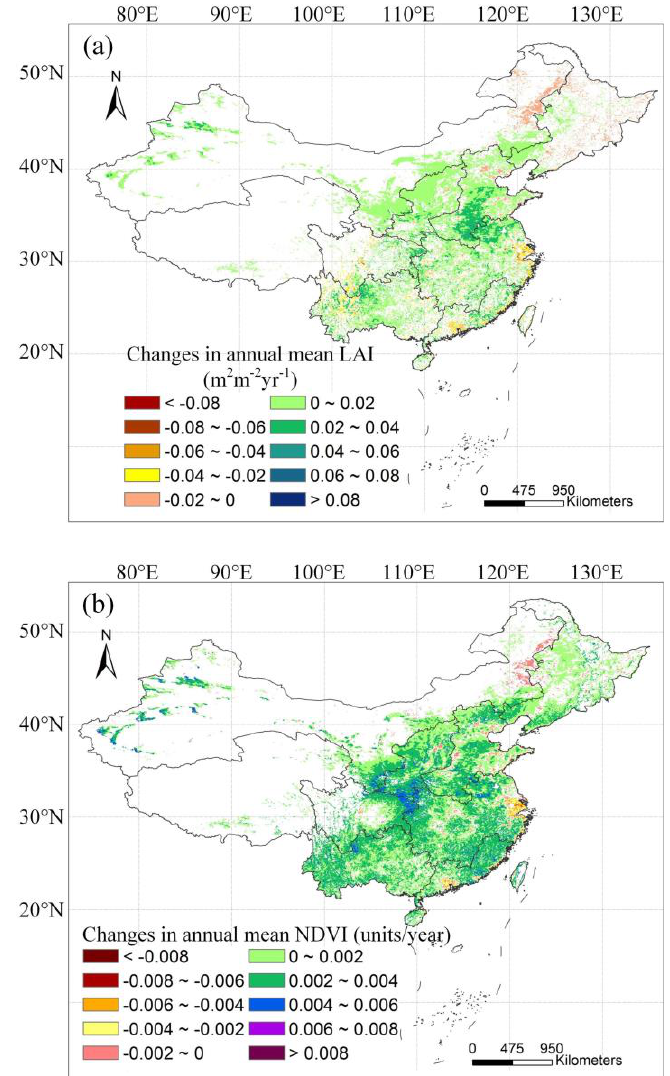
Figure 3. Spatial distribution of greenness trends characterized by ( a ) GLASS LAI and ( b ) GLASS NDVI from 1982 to 2015 in Chinese croplands.